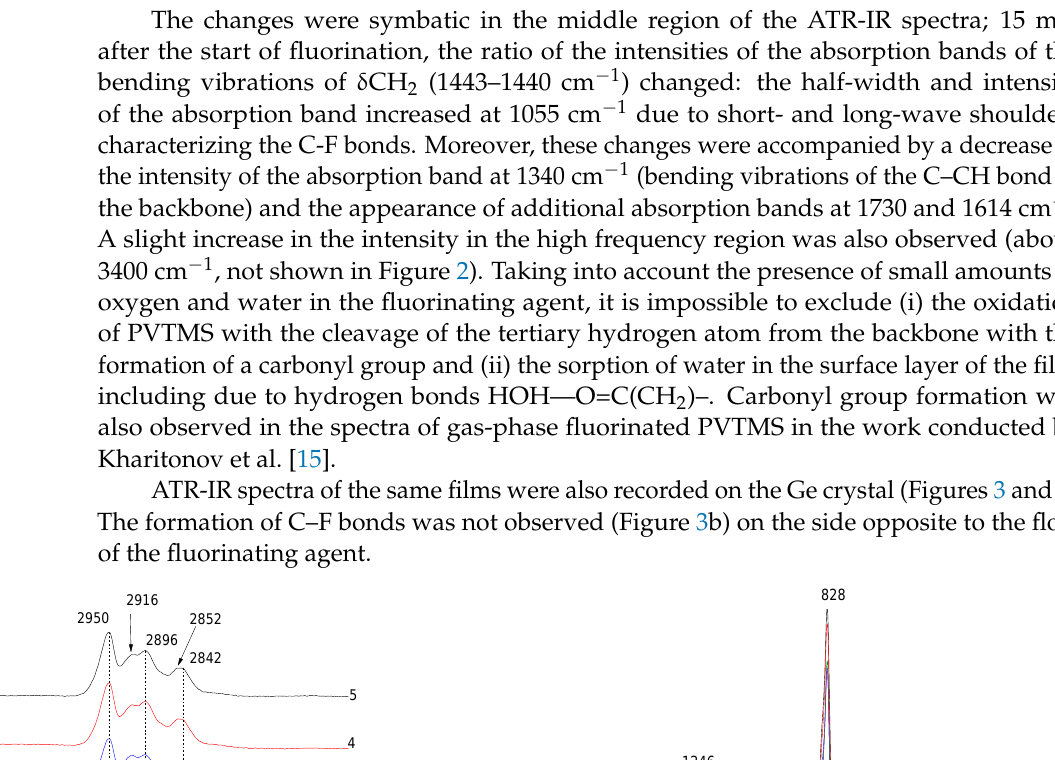
( b ) Figure 4. Fragments (( a ): 2600–3200 cm −1 region; ( b ): 600–1800 cm −1 region) of ATR-IR spectra (Ge crystal) of the PVTMS film recorded on the side of fluorination. Curve 1: original film; curves 2–5: films fluorinated for 15, 30, 45, and 60 min, respectively. The changes were more significant on the side of fluorination and, in general, coincided with the changes described above for the ATR-IR spectra recorded on the ZnSe crystal. The appearance of the shoulder at 1270 cm −1 on the absorption band of the H–C–H bending vibrations in methyl groups (1240–1250 cm −1 ) can be attributed to the appearance of Si(CH 3 ) 2 groups, which may indicate either fluorination of the Si(CH 3 ) 3 at one of the methyl groups or the methyl group cleavage from the Si(CH 3 ) 3 . Two intense absorption bands in the long–wavelength region of the spectrum (at 820 and 740 cm –1 ) belong to the Si–C stretching vibrations, with the Si–CH 3 bond making a larger contribution to the first band, and the Si–CH bond of the polymer backbone making a larger contribution to the second band. The appearance of short–wave shoulders on these absorption bands allows one to conclude that only methyl groups within Si(CH 3 ) 3 were fluorinated during the first 30 min of fluorination, and only monofluorinated groups formed; then difluorinated (changes in the region of 1240 cm −1 ) and trifluorinated (bands